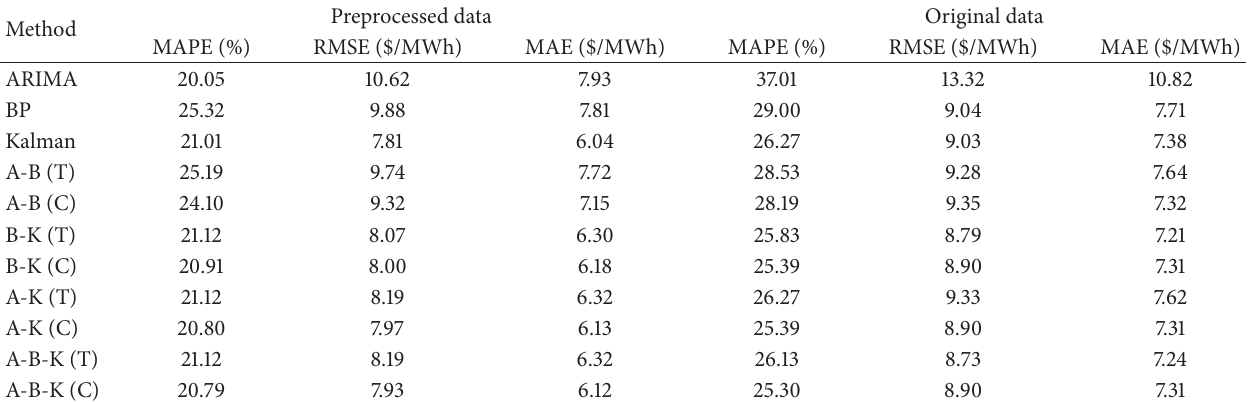
Table 8: Comparison of forecasting models built using preprocessed data and original data.